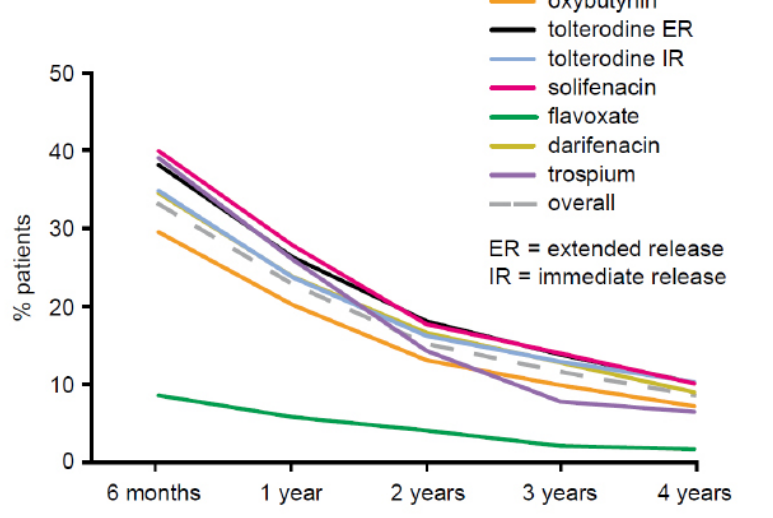
Figure 2. Percentage of Patients Remaining on OAB Therapy, according to First-prescribed OAB